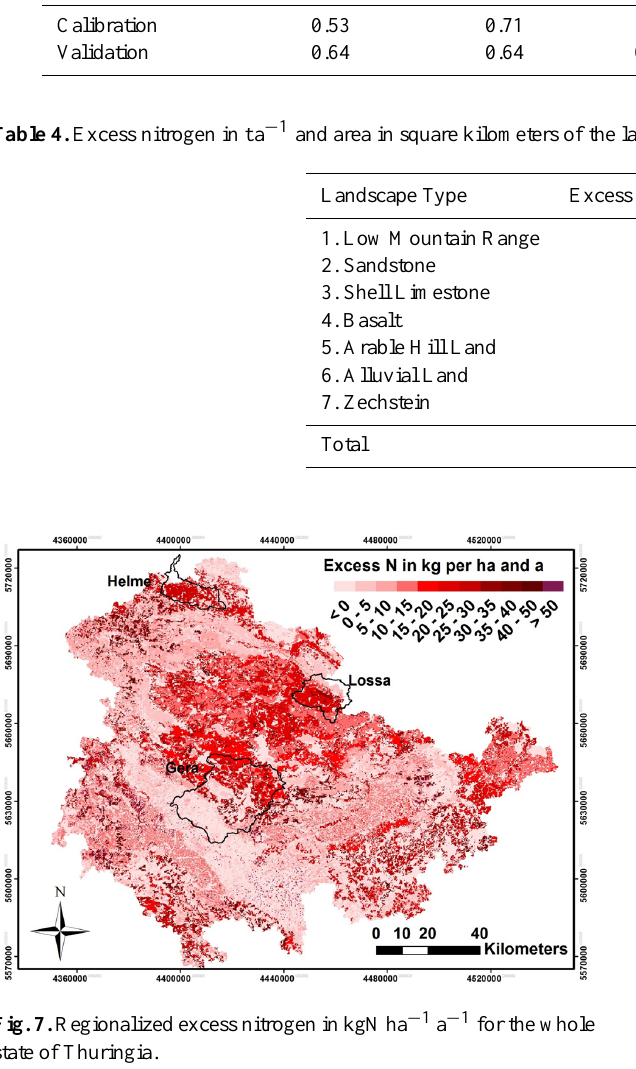
Table 3. Correlation coefficients (R) of the calibration and validation data set for the Thuringian landscape types. Landscape Type